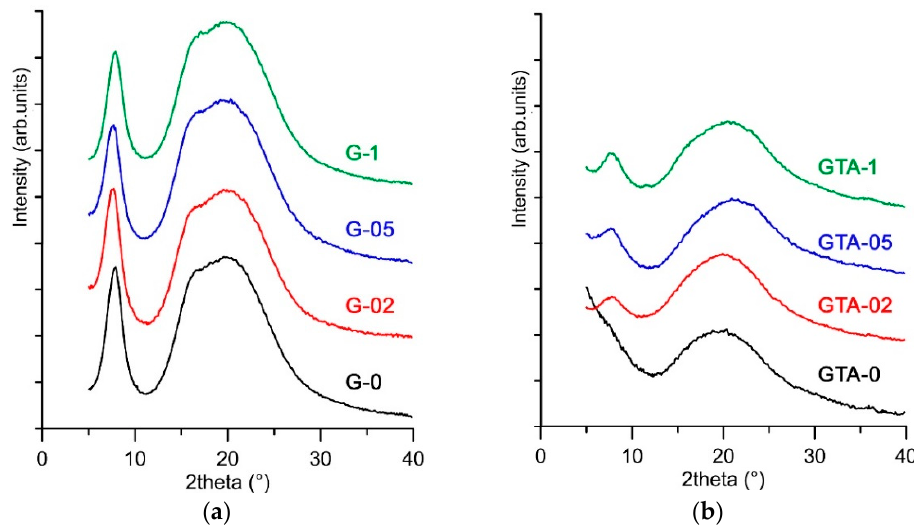
Figure 8. X-rays diffraction patterns of ( a ) G films and ( b ) GTA